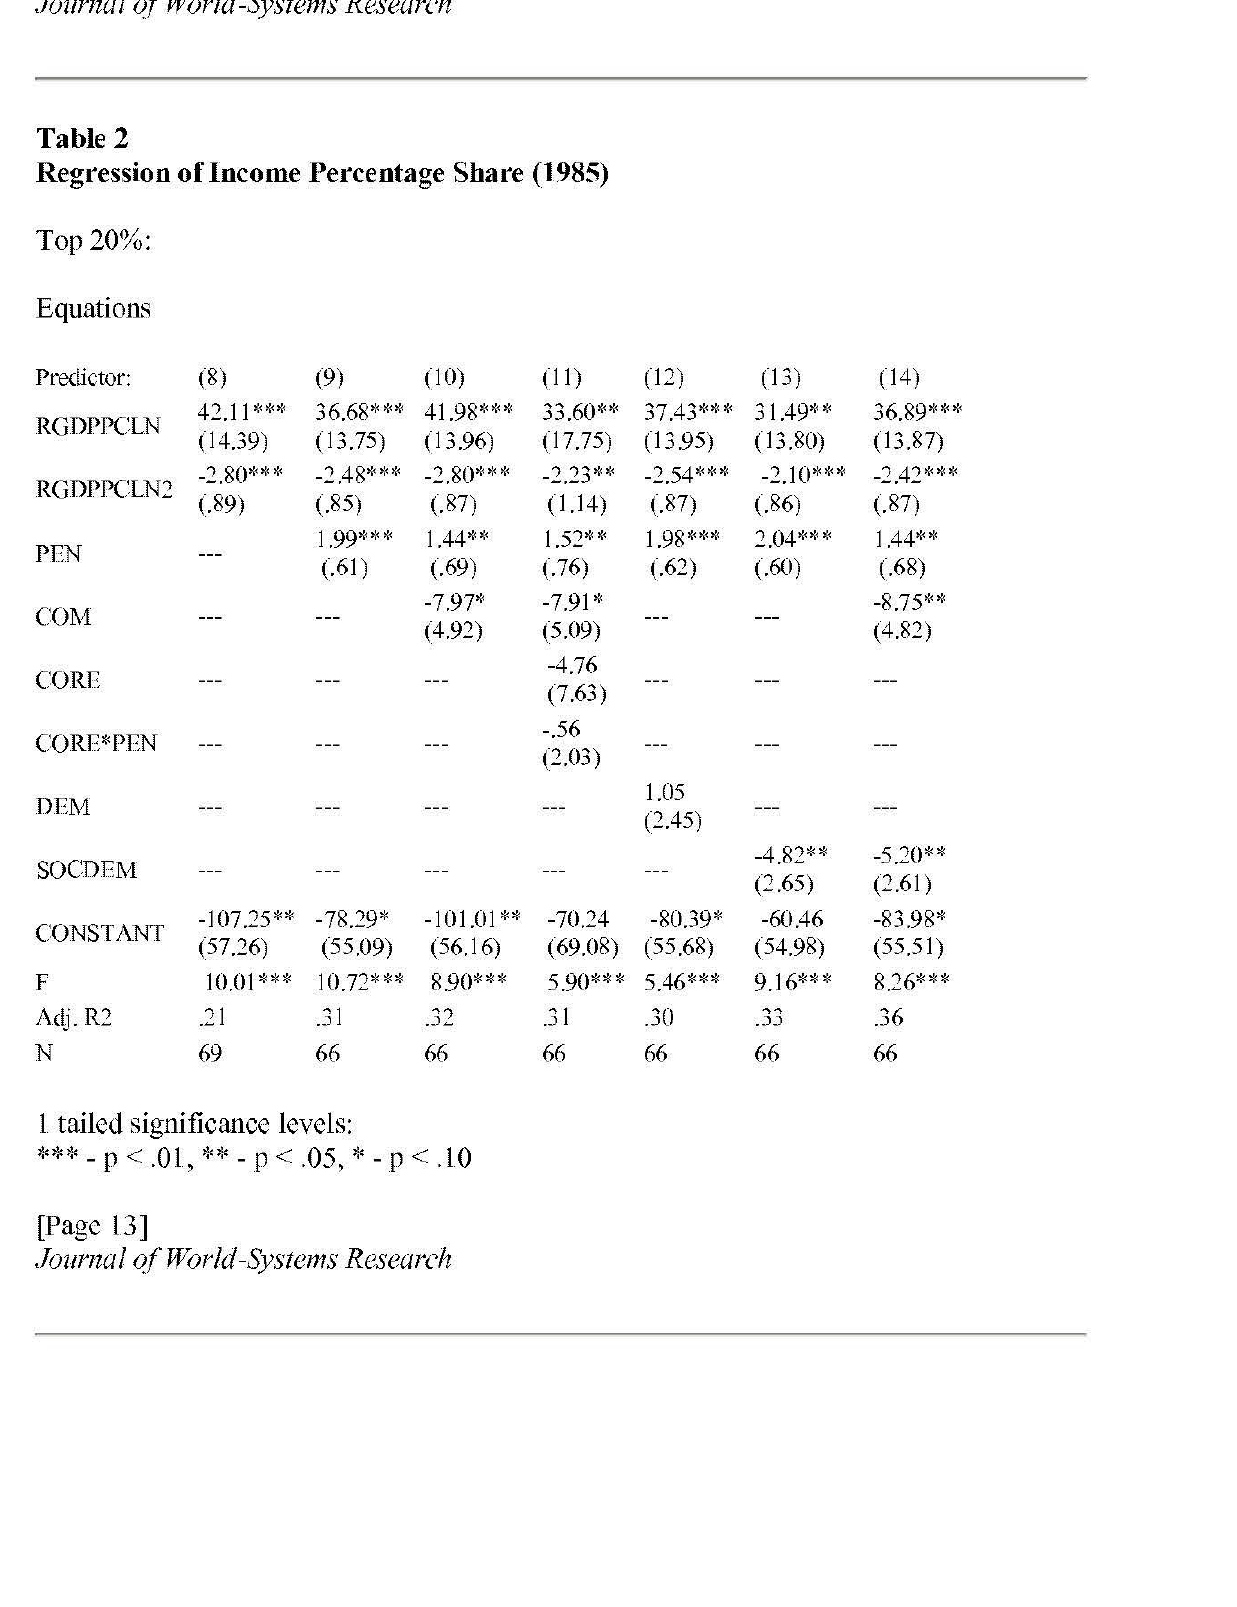
Regression of Income Percentage Share